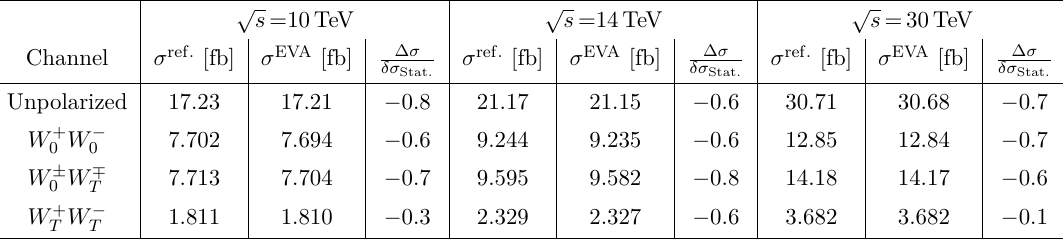
Table 9 . For the process W + W − → tt in multi-TeV µ + µ − collisions, EWA-level cross sections [fb] λ A λ B as reported by ref. [26] ( σ ref . ) , the cross section computed with mg5amc ( σ EVA ) , and the statistical pull (∆ σ/δσ ) , for (top row) unpolarized W + W − , (second row) W + Stat . √ and (bottom row) W + scattering, at W − s = 10TeV (left), 14 TeV(center), and 30 TeV (right). The T T mg5amc statistical uncertainty corresponds to 400k events, or δσ Stat . ≈ ± 0 . 16%